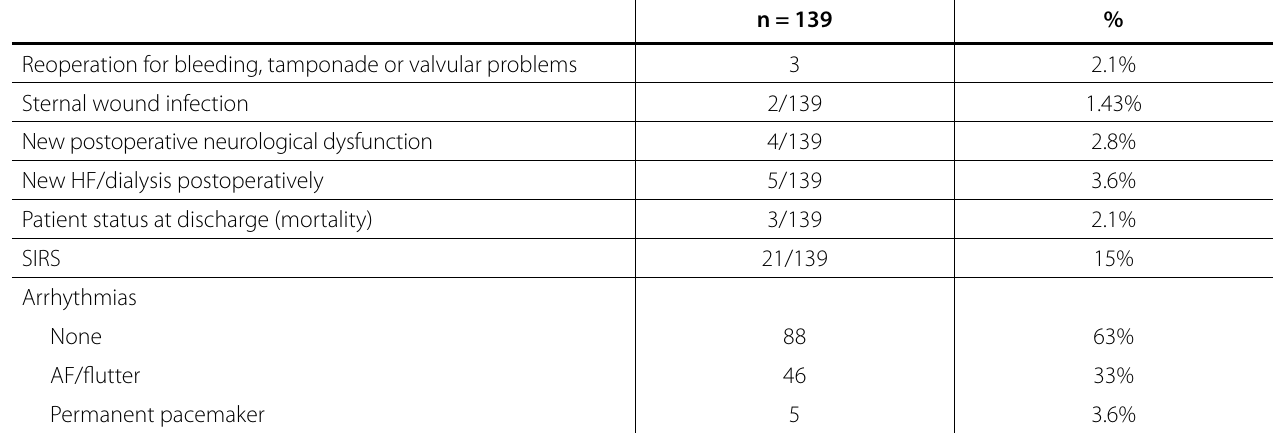
Table 3. Postoperative